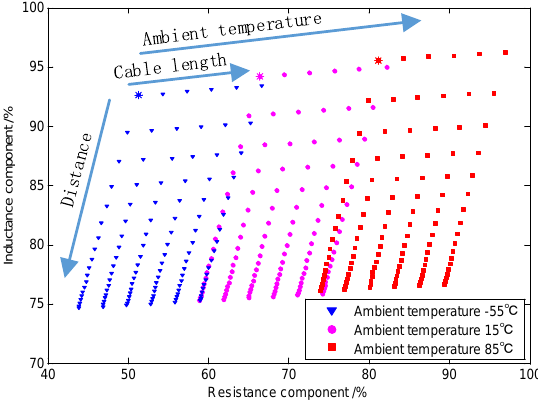
Figure 1. Block diagram of single-sensor-coil structured inductive proximity sensor (IPS). 20 mA), the current-limiting resistances of the response circuits ( R n and R f ) are chosen as 300 Ω . Figure 2. Relationships between vector impedance of the response circuit and environmental factors.